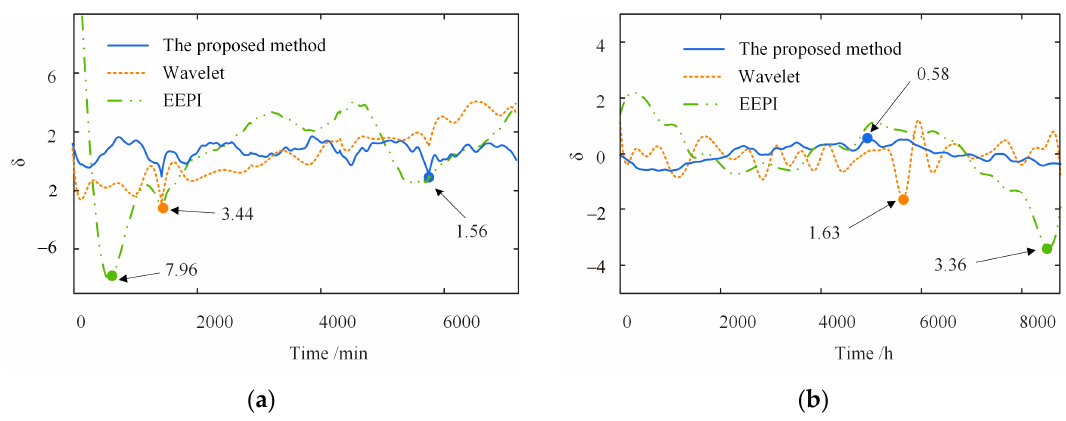
Figure 10. Separation error in different time windows. ( a ) Five days; ( b ) one year.